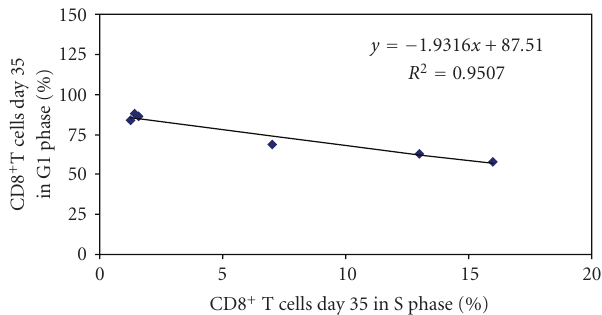
Figure 6: Alterations in the cell cycle distribution of patient versus norma donor anti-tumor CD8 + T cells. A statistically significant, negative correlation was observed between G1 and S percentages in 3 RCC